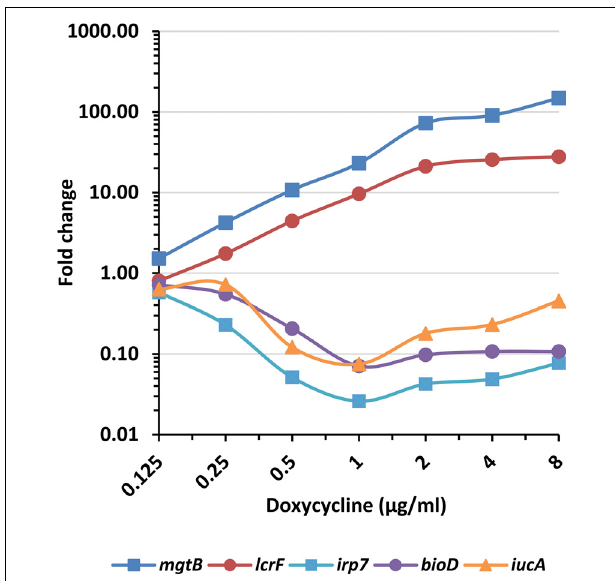
FIGURE 2 | Expression pattern of the doxycycline-responsive genes. Y. pestis Kim53 bacteria were exposed for 2 h to the indicated concentrations of doxycycline. The bacterial cultures were then harvested, RNA was extracted and the FCs in the expression levels of the indicated genes, compared to their levels in an unexposed bacterial culture, were determined by qRT-PCR. mgtB and lcrF are upregulated genes, while irp7 , bioD, and iucA are downregulated.